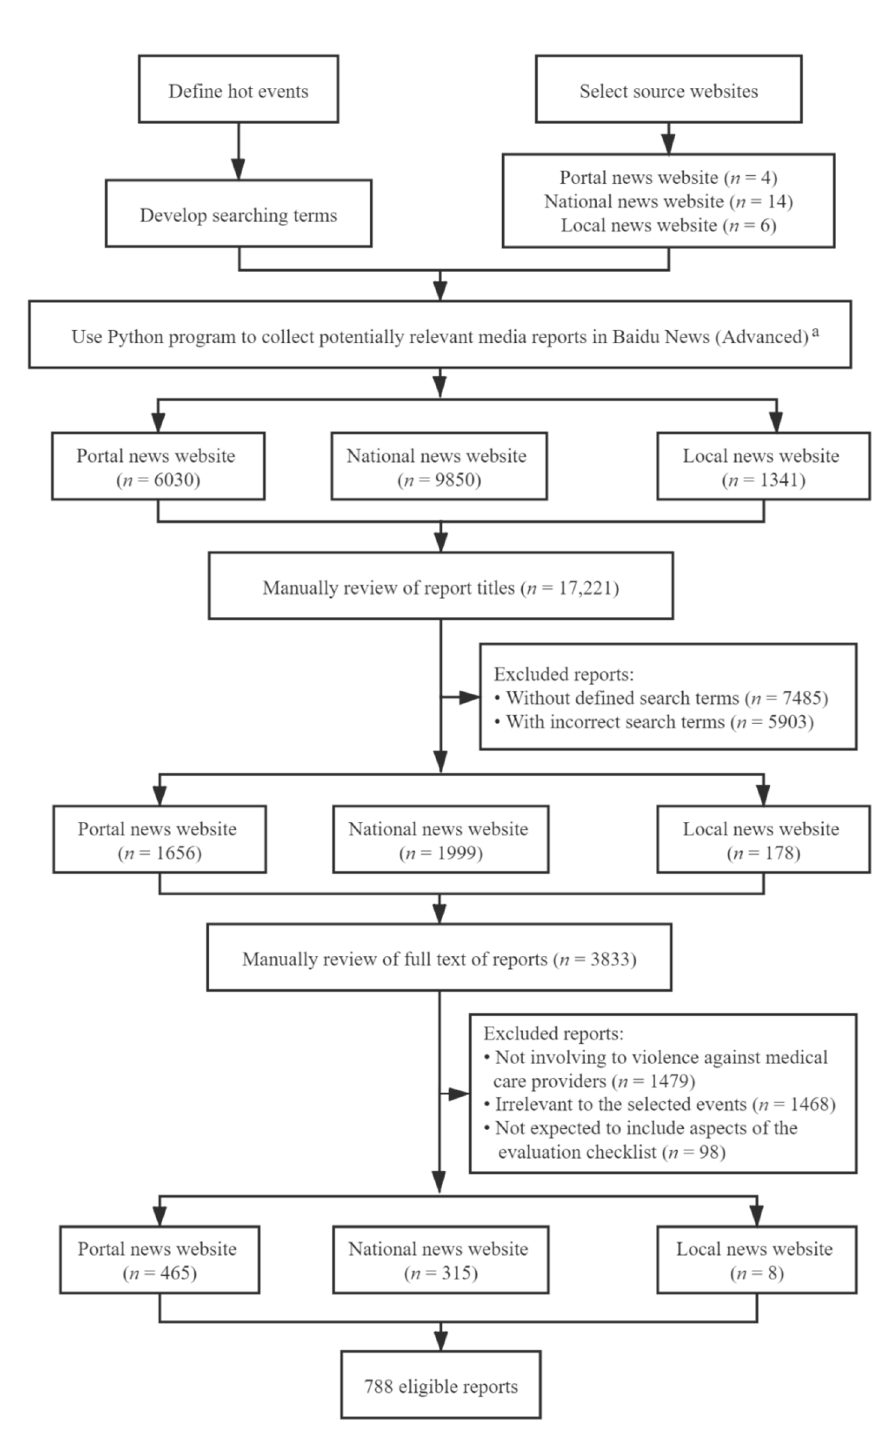
Figure 1. Flow chart of selection of eligible media reports about violence against medical care providers. Note: a Unlike academic datasets, Baidu News does not support exact searching and therefore can generate irrelevant records.